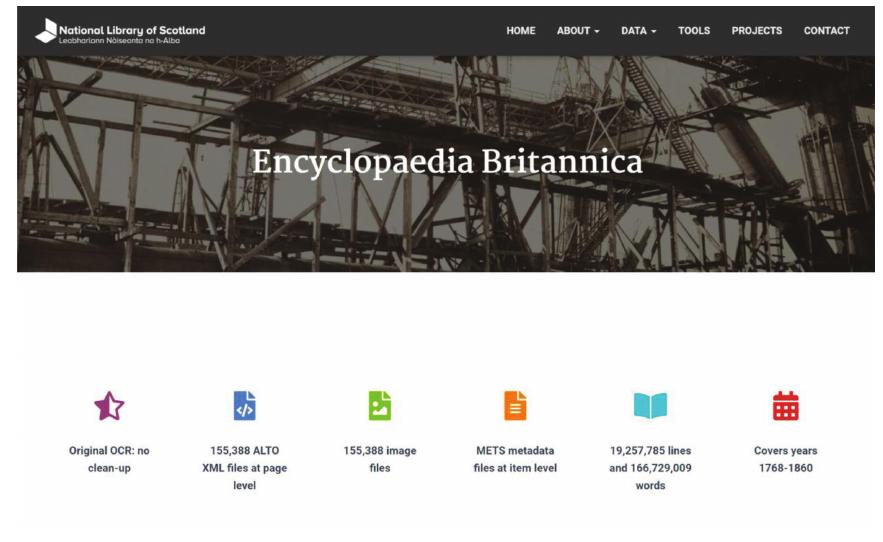
Fig. 1: Example of a dataset on the Data Foundry, with key points about the data provided.